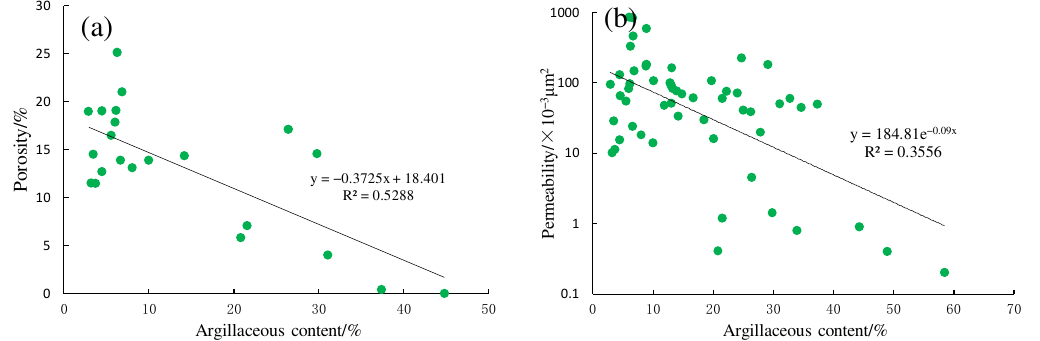
Figure 12. Relationship between shale content and physical properties of Z Ⅱ 3 in the Wang Guantun area ( a ) argillaceous content and porosity ( b ) argillaceous content and permeability .